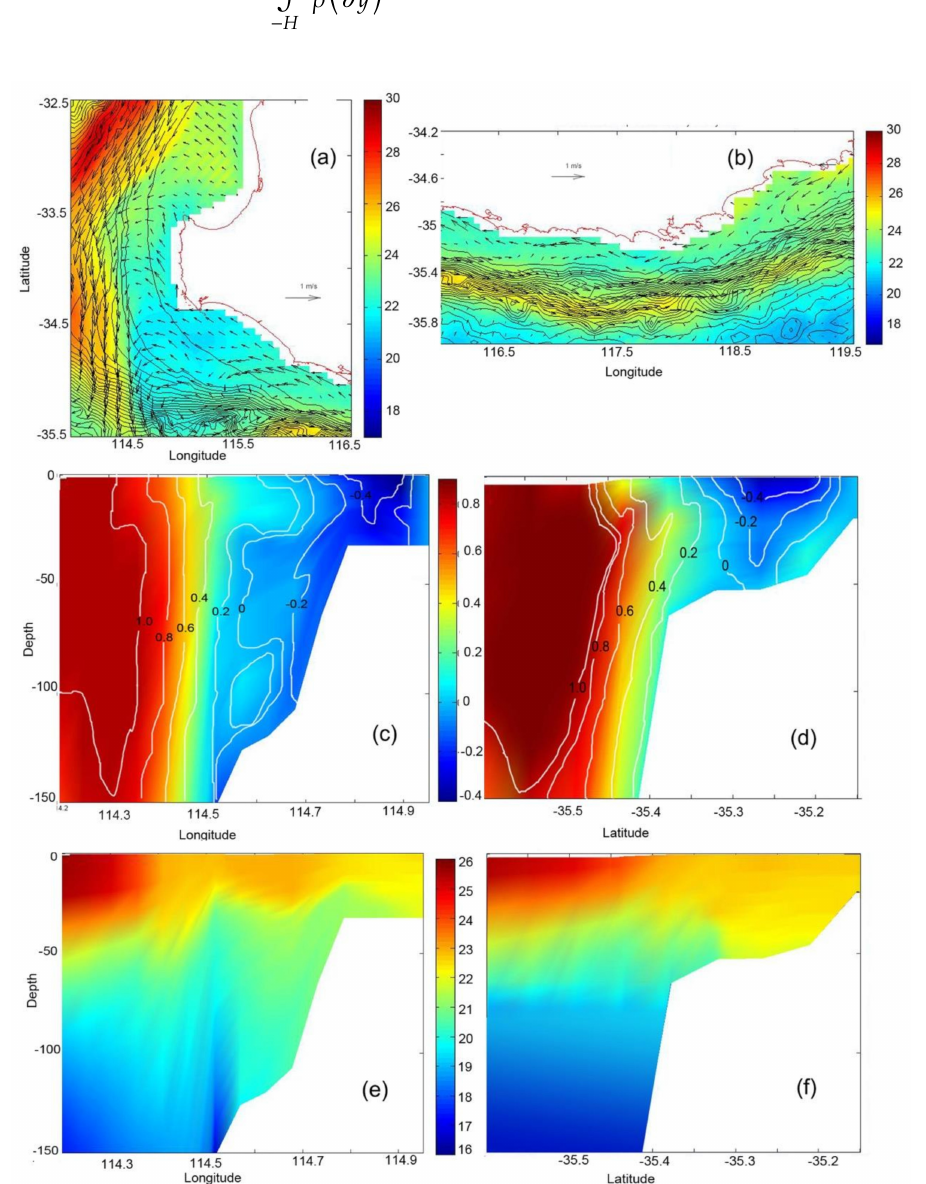
Figure 9. ( a ) Sea surface temperature ( ◦ C) and Capes current velocity for the Capes region in summer. ( b ) Sea surface temperature ( ◦ C) and Cresswell current velocity for the Albany region in summer. ( c ) Transect R cross-section of the Capes current north-south velocity (m / s) in summer. ( d ) Transect K cross-section of the Cresswell current north-south velocity (m / s) in summer. ( e ) The Capes current summer temperature ( ◦ C) at transect R (Capes region). ( f ) The Cresswell current summer temperature ( ◦ C) at transect K (Albany). The color bars indicate the current velocity in ms − 1 . Here, z is the vertical coordinate; y is the alongshore direction; H the local water depth; ∂ P / ∂ y is the alongshore geopotential gradient; ρ is mean density; u * is the friction velocity at the air–sea interface; C D is the bottom drag coe ffi cient; and V B is the alongshore velocity just above the bottom friction layer. In the Equation (1), term 1 represents the depth-integrated alongshore